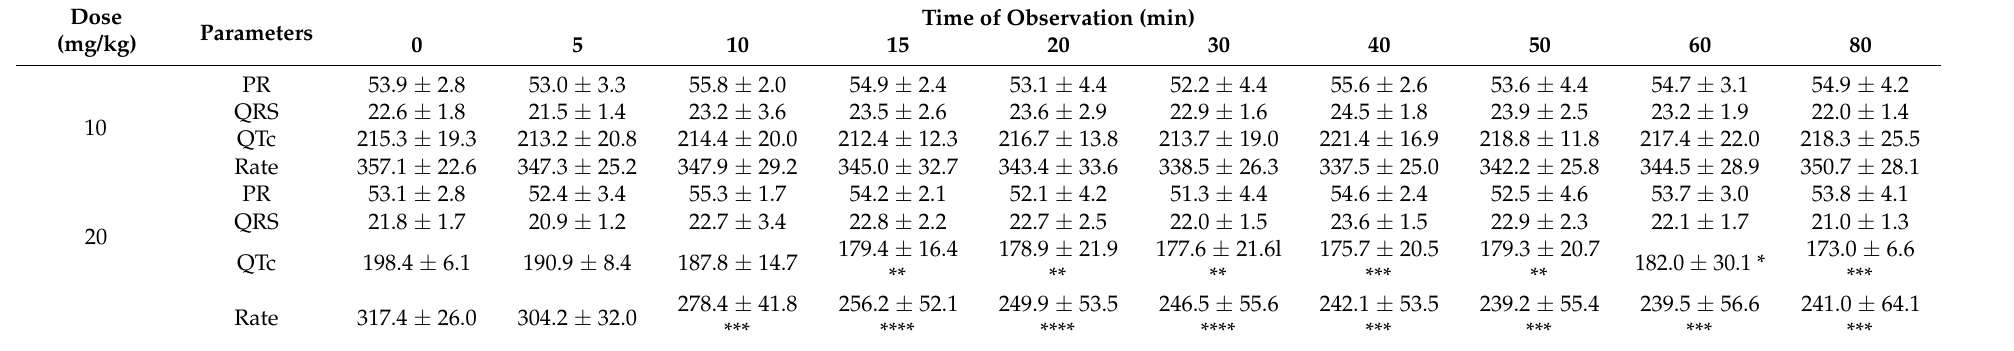
Table 3. The effect of HBK-10 on the normal ECG in